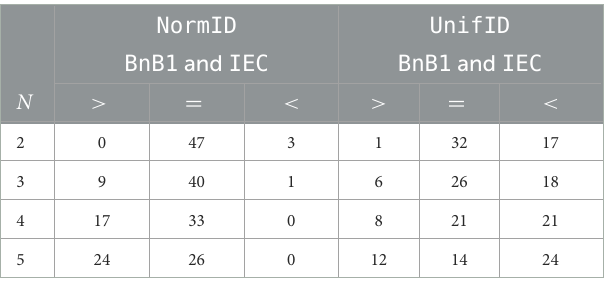
TABLE 3 Objective values comparison with BnB1 and IEC for UnifID and NormID .